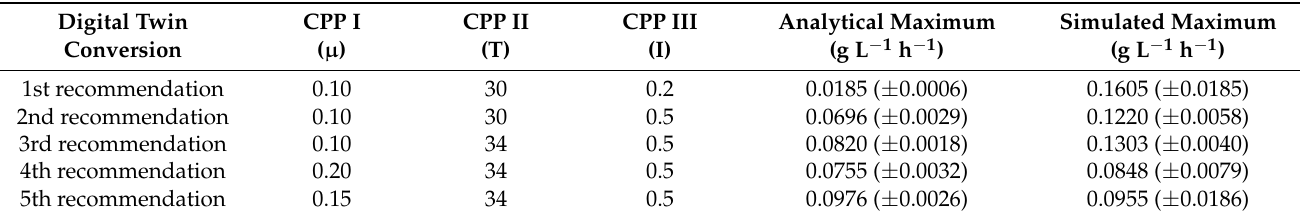
Table 1. Progression of the model-based DoE until the optimum was found using five initial experiments. Digital